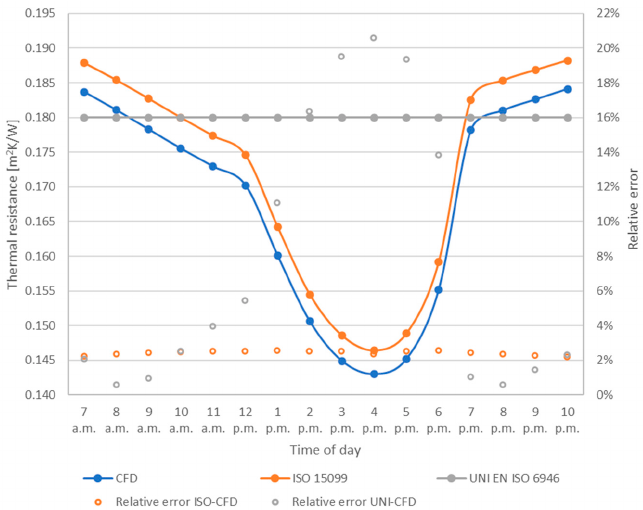
Figure 5. Comparison between the hourly thermal resistance values for the closed cavity provided by the CFD simulations and following the ISO 15099 and UNI EN ISO 6946 calculation proce- dures. The graph shows also the RE of the CFD results compared with the standards at each